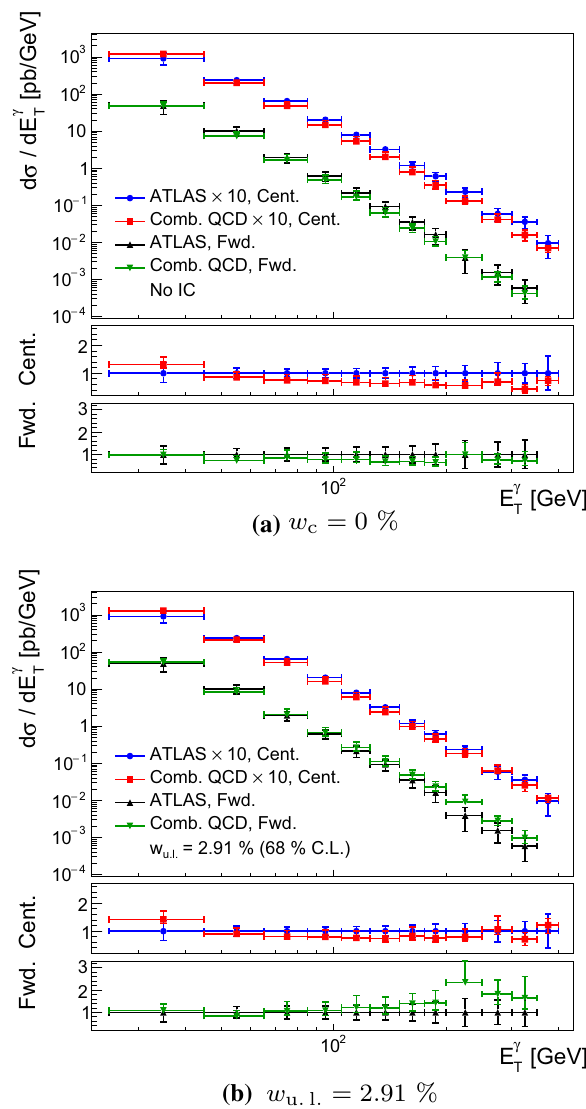
Fig. 2 The spectrum of prompt photons as a function of its transverse γ calculated with the combined QCD analysis, compared to energy E T ATLAS data [32]. a Top: the spectrum in the central rapidity region | η γ | < 1 . 37 and forward 1 . 56 ≤ | η γ | < 2 . 37 region without the IC contribution; a middle: the ratio of the MC calculation to the data for the central rapidity region ( w c = 0%); a bottom: the ratio of the MC calculation to the data for the forward rapidity regions ( w c = 0%). b The same spectra, as in ( a ), but with upper limit of IC contribution w = 2 . 91 % corresponding to the best fit of the u . l .